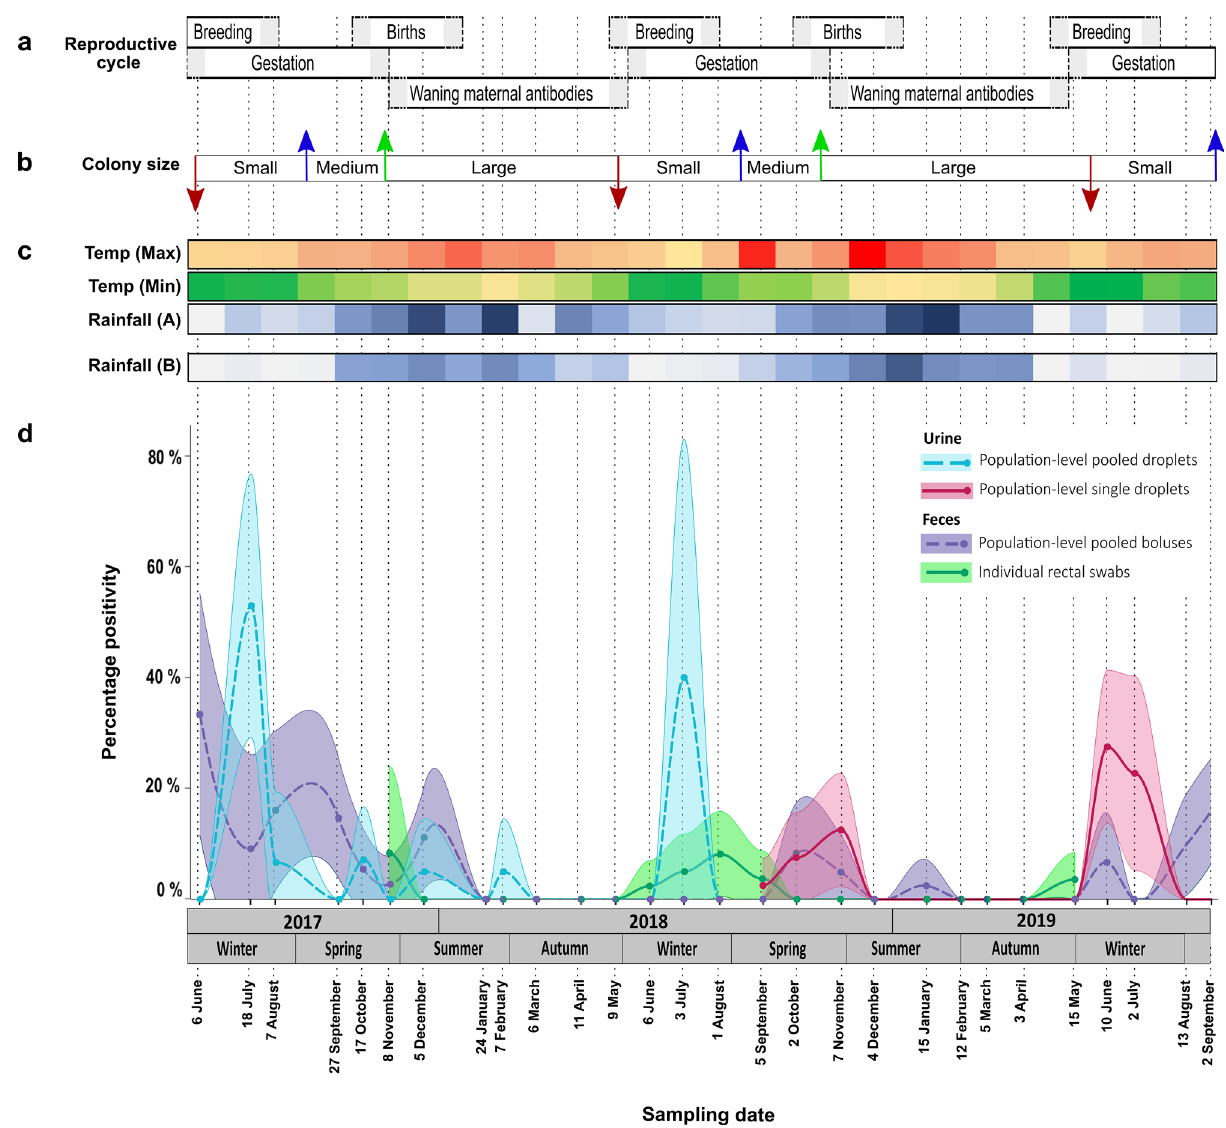
Figure 1. Detection of paramyxoviral RNA in a population of Egyptian rousette bats and descriptive host and environmental considerations from Matlapitsi cave, Limpopo Province, South Africa, 2017–2019. ( a ) Estimated stages over the reproductive cycle of the Egyptian rousette bat populations in South Africa (based on unpublished observations made during catch-and-release sampling and previous findings) 42 . Shaded areas represent an early and late estimate for each stage; ( b ) Colony size variation across the sampling period defined as small—when the population size is at its lowest (~ 3000), medium—when the roost is recolonized before the birthing season (~ 7000), and large—following the birthing pulse (> 9000) 42 . Red arrows indicate the periods of mass departure from the roost near the end of May, the blue arrows represent recolonization of the roost in spring, and the green arrows indicate the influx of naïve individuals during the birthing pulse; ( c ) Monthly climate data (maximum and minimum temperatures and rainfall (A) from the closest weather station to the roost and additional rainfall (B) data from a closely situated rain station. The maximum temperature color scale bar ranges from light red to dark red (22–32.6 °C), minimum temperatures from green to light orange (8.4– 19 °C), and rainfall from light to dark blue (0–168 mm); ( d ) Percentage positivity of urine, fecal and rectal swab samples for henipa- and related viral RNA detected monthly over the longitudinal sampling period calculated per monthly sampling event. Colored dots represent raw point data, with dashed lines showing values predicted by a loess function in R. Shaded areas represent 95% confidence